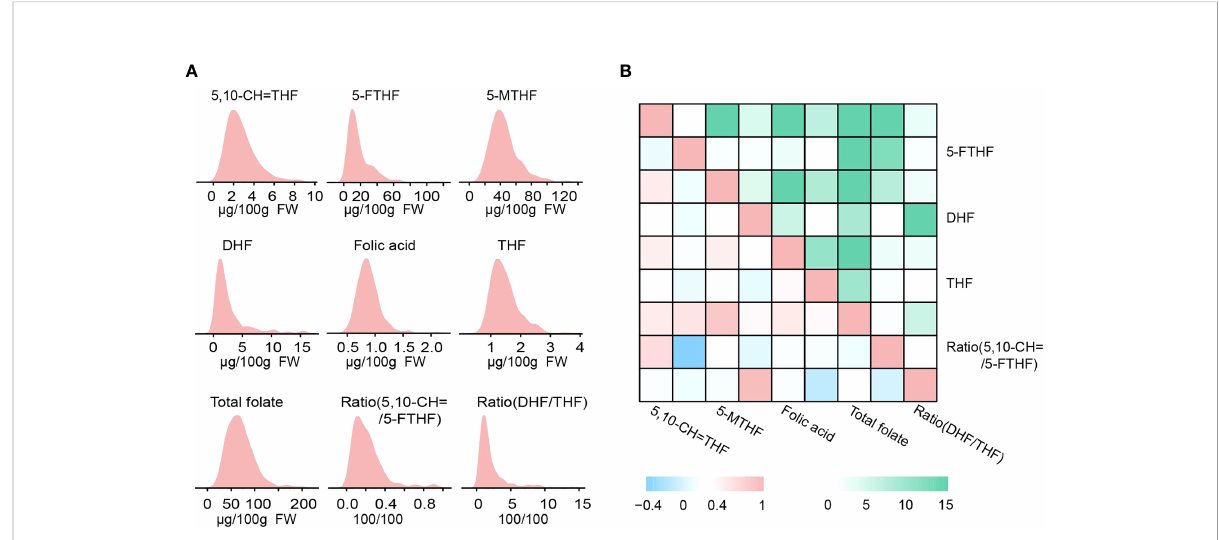
FIGURE 1 Phenotypic variation of nine folate traits in this study. (A) Phenotypic distribution of nine folate traits in the population. (B) Pearson correlation coef fi cients (bottom left) for the nine traits and – log 10 ( P -value) of the Pearson correlation (upper right).